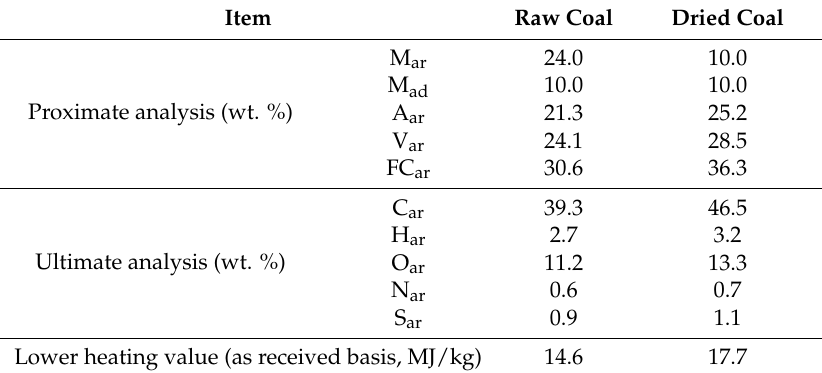
Table 3. Proximate and ultimate analyzes of the raw coal and dried coal. Item Raw Coal Dried Coal